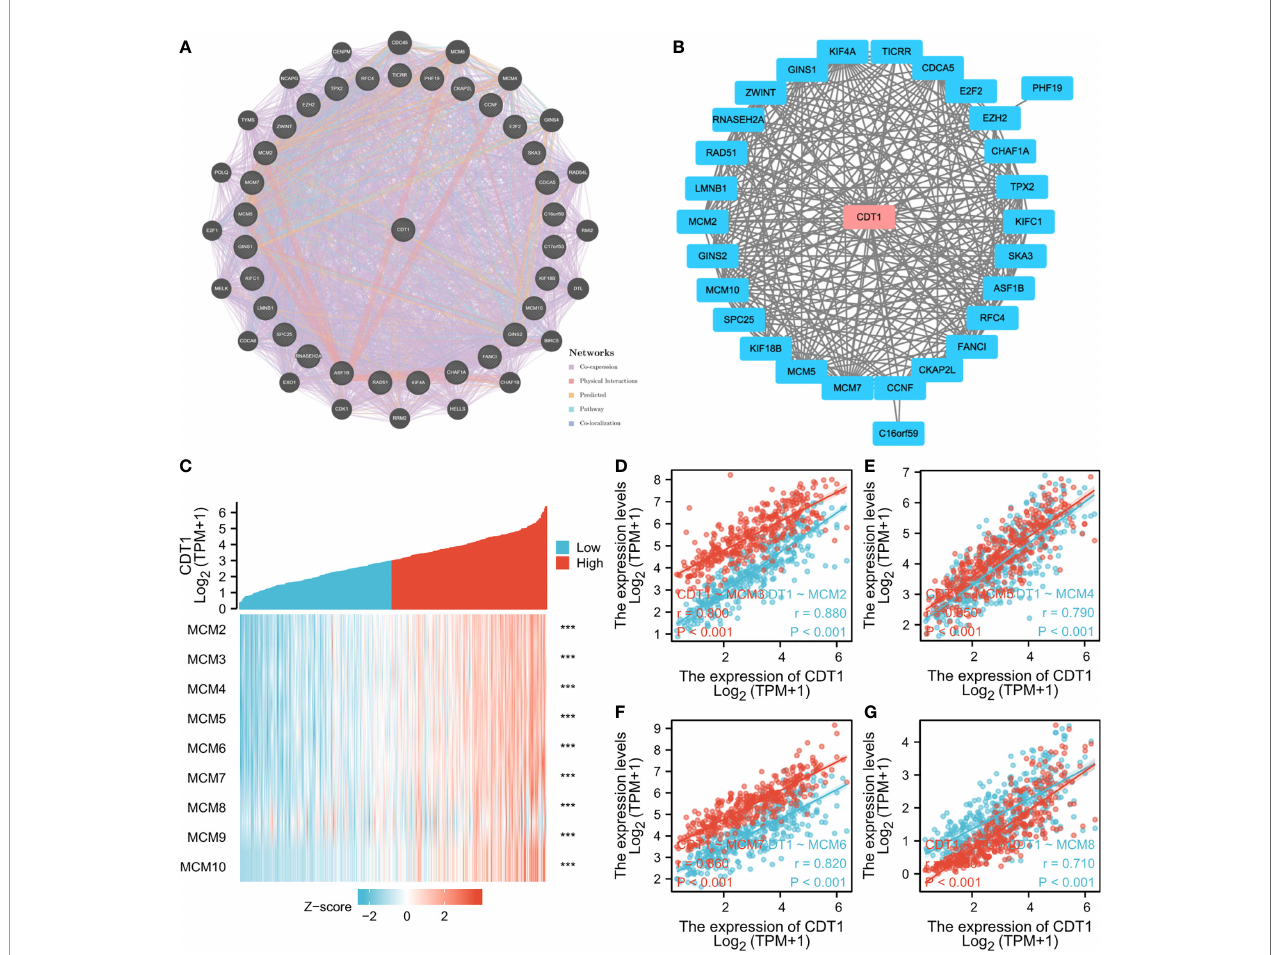
FIGURE 8 | (A, B) Interaction network of CDT1 and their most similar genes on GeneMANIA (A) and STRING (B) datasets. (C) Heatmap of the expression of MCM family genes in HCC samples with CDT1 high and CDT1 low expression. (D – G) Scatter plot results using Spearman correlation analysis between MCMs and CDT1 at the transcriptional level. *** p <